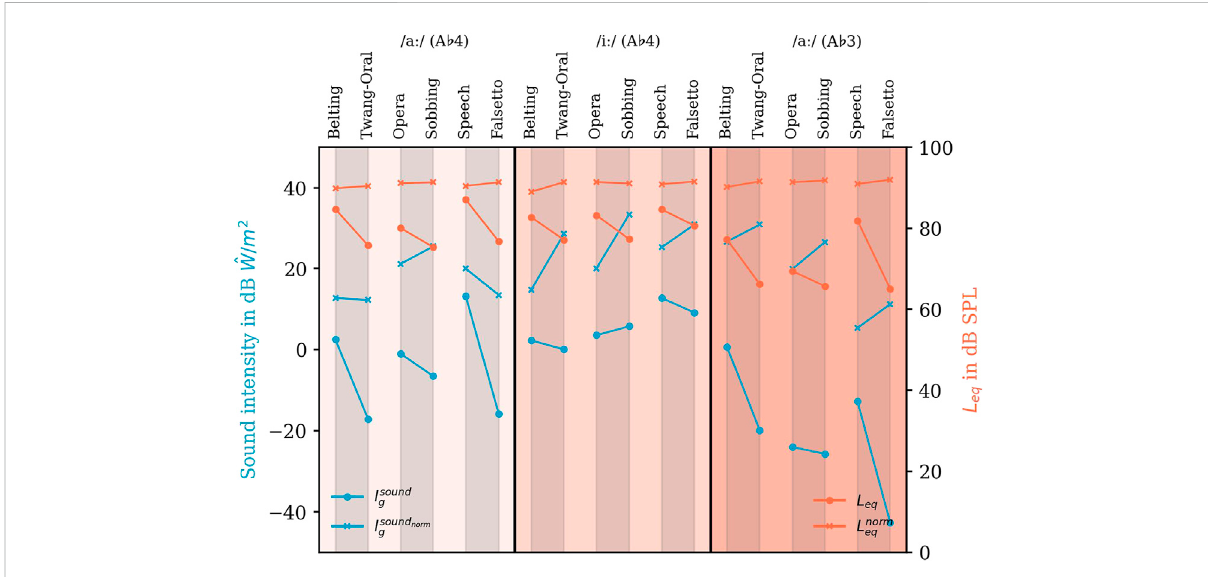
FIGURE 9 Soundintensity I sound g (indB ^ W /m 3 ,leftordinate,bluecolor)andequivalentsoundpressurelevel L eq (indBSPL,rightordinate,orangecolor),and their loudness-normalized counterpart ( I sound norm